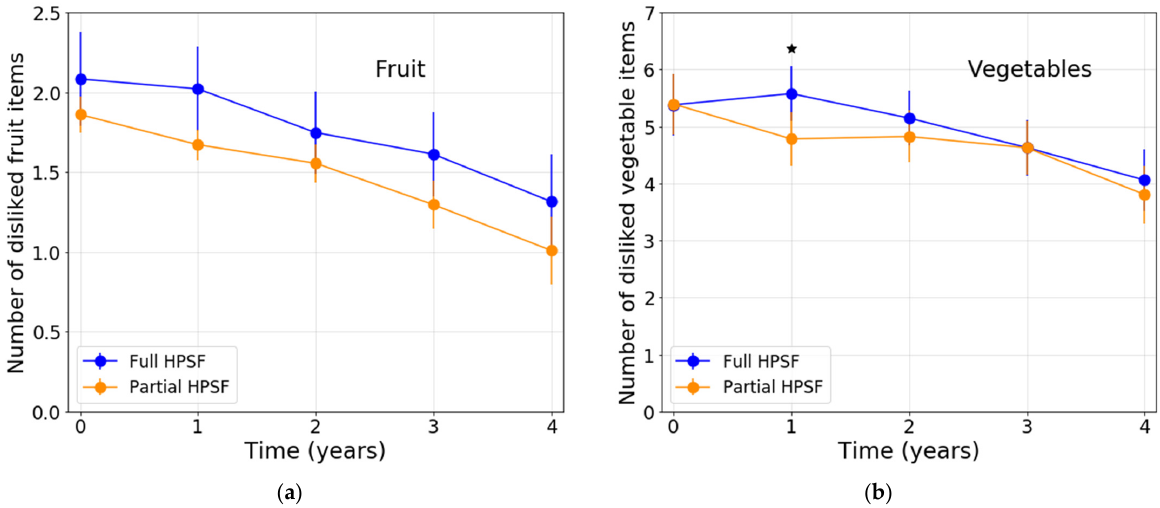
Figure 3. Estimated means of children’s fruit and vegetable preferences at T0–T4: ( a ) Number of disliked fruit items; ( b ) Number of disliked vegetable items. Note. All analyses were adjusted for sex, study year at T0, SES, and ethnicity. Abbreviations: HPSF, Healthy Primary School of the Future. ★ Significant ( ≤ 0.05) difference between full and partial HPSF after correction for baseline.